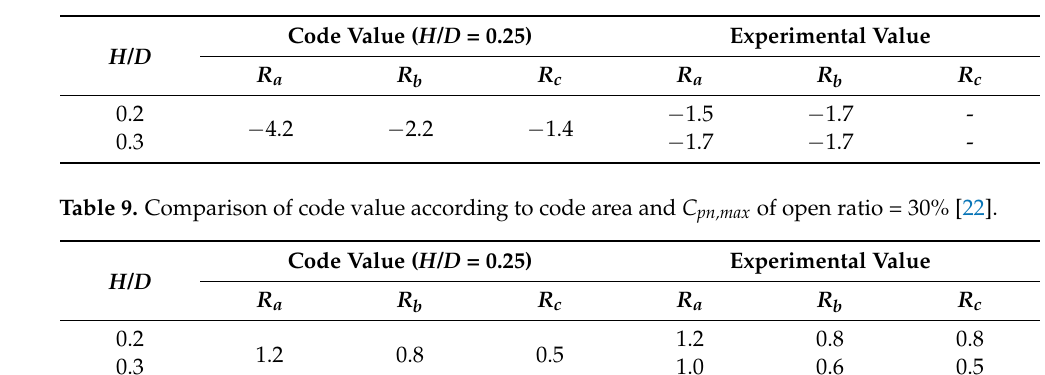
Table 8. Comparison of code value according to code area and C pn,min of open ratio = 50% [22]. Code Value ( H / D = 0.25) H / D